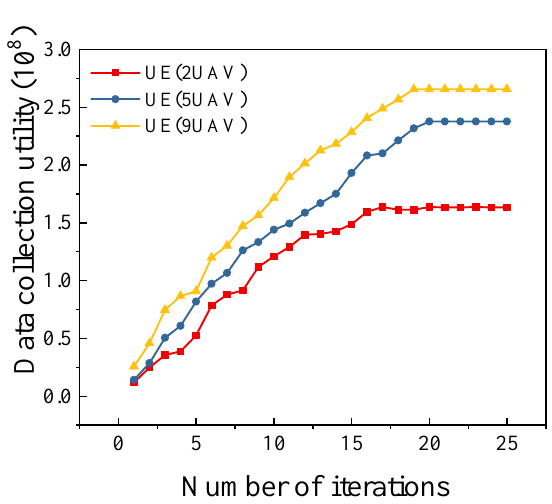
Figure 5. Convergence of UEAlgorithm ( k =